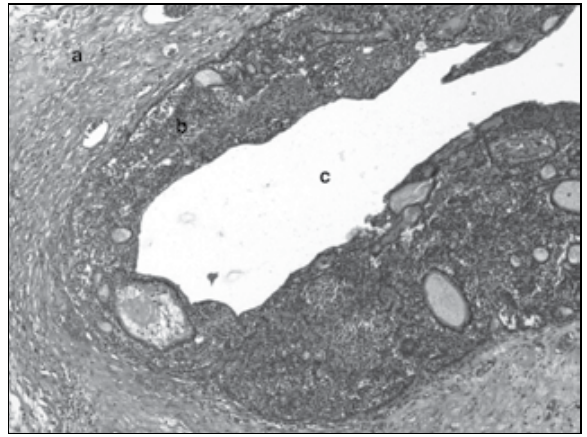
Figura 4 – Aspecto histopatológico (a) cápsula de tecido conjuntivo; (b) tecido epitelial; (c) luz do cisto (HE, 100×). HE: hematoxilina e eosina.